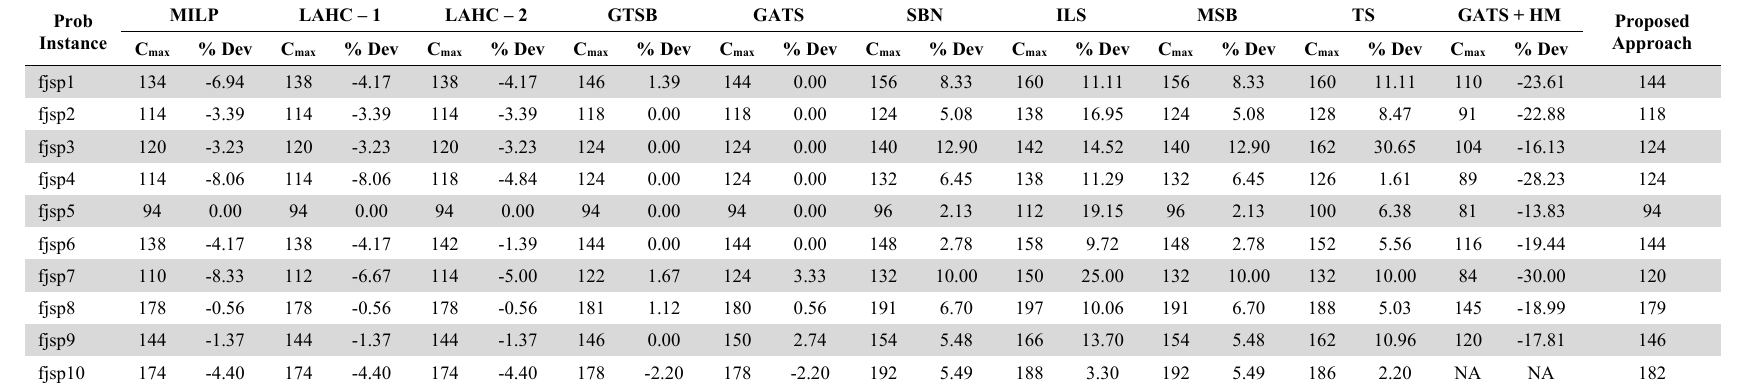
Comparison of Proposed Approach Results for Problem Set 4 for C max